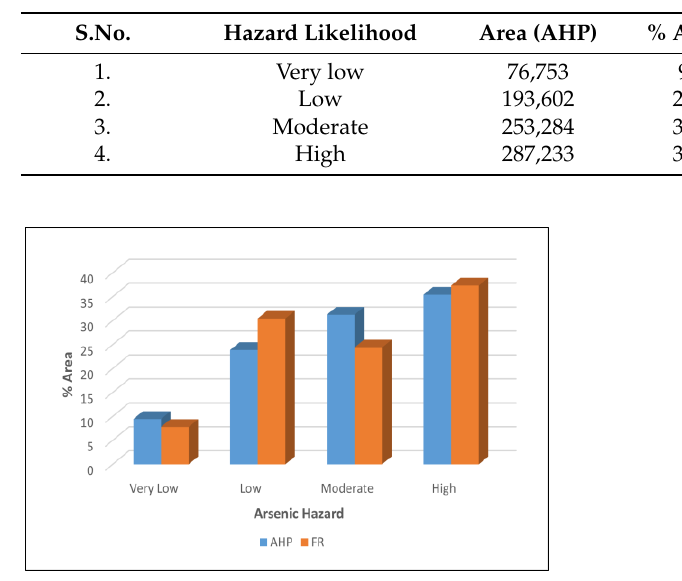
Figure 5. Bar graph of groundwater arsenic prediction by geostatistical methods.